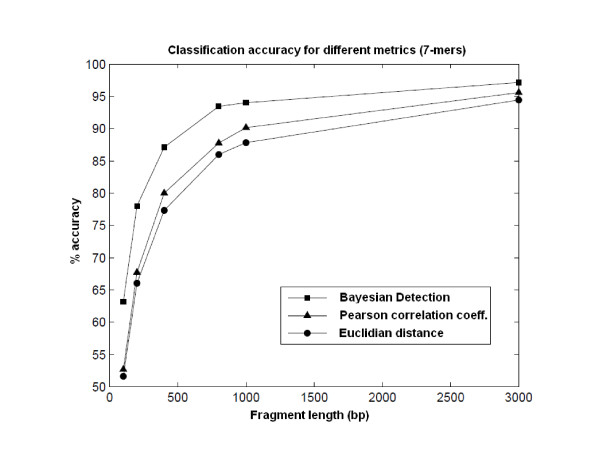
Classification accuracy for different distance metrics. The accuracy performance of different distance/similarity metrics for 28 taxa with varying fragment lengths is shown. The frequencies of 7-mers were used. Using the metric defined by Sandberg et al. appears to be more accurate for all fragment lengths than employing Euclidean distance and Pearson correlation coefficients.